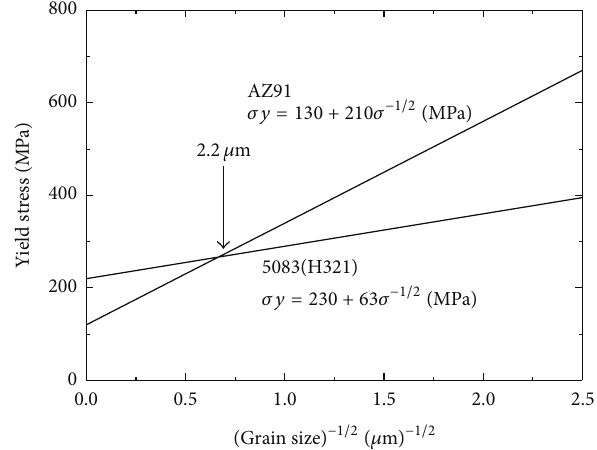
Figure 7: Yield strength and grain sizes of AZ91 and 5083 alloys [4].